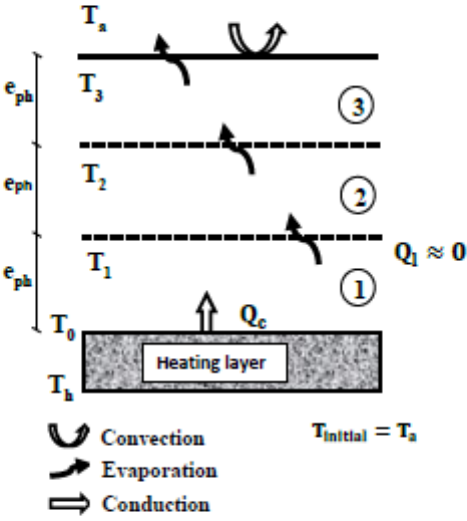
Figure 2. Thermal model of the conductive drying of PHWWC.